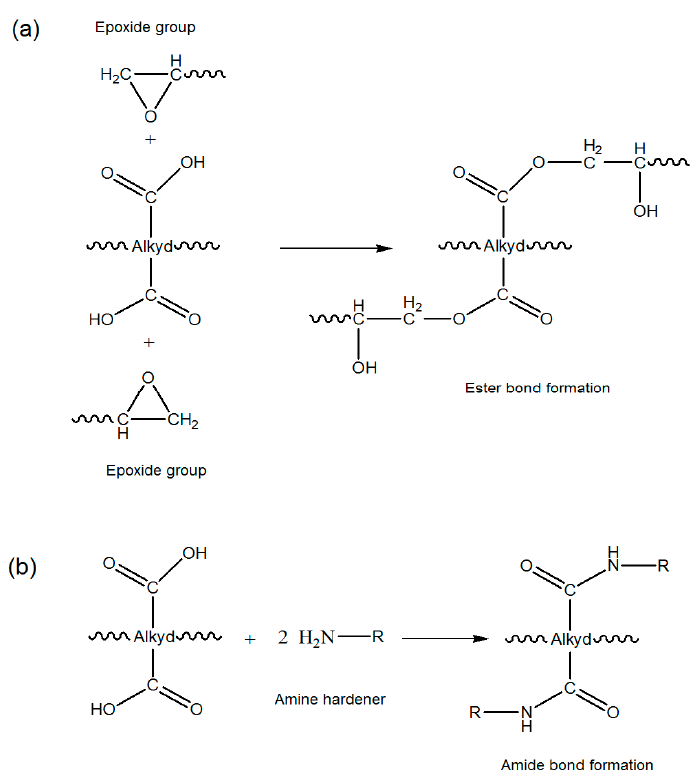
Figure 15. Scheme of plausible reactions of carboxylic groups of alkyd with: ( a ) Epoxy; and ( b ) Amino group. Polymers 2016 , 8 , 125